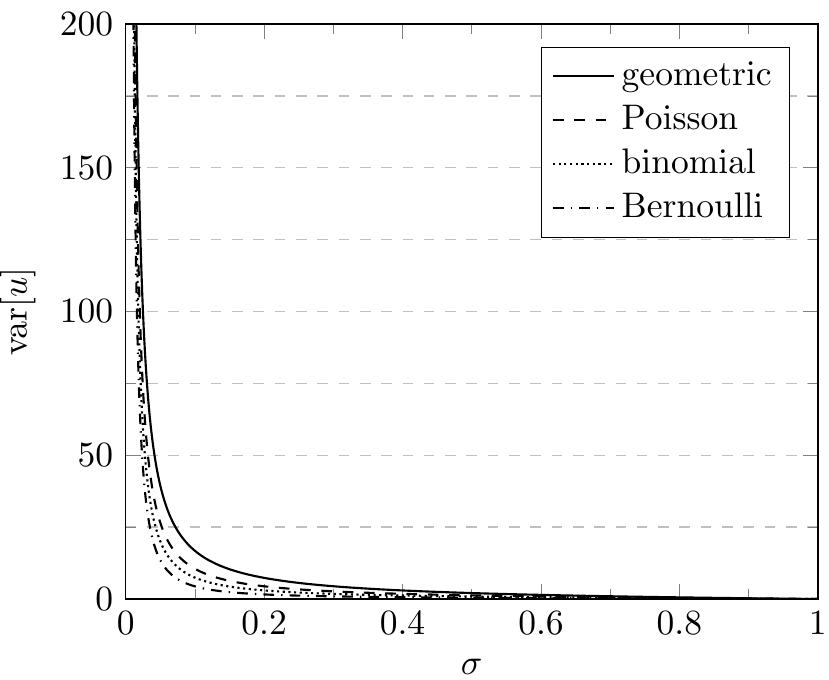
Figure 11. Variance of the system content var [ u ] versus σ , for geometric service times with µ = 0.75, λ = 0.9 and various distributions for the number of arrivals per slot.